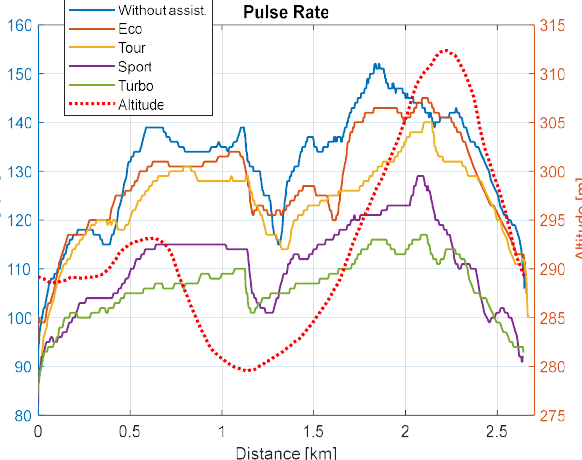
Figure 16. Graph of heart rate as a function of the distance traveled and the support mode.